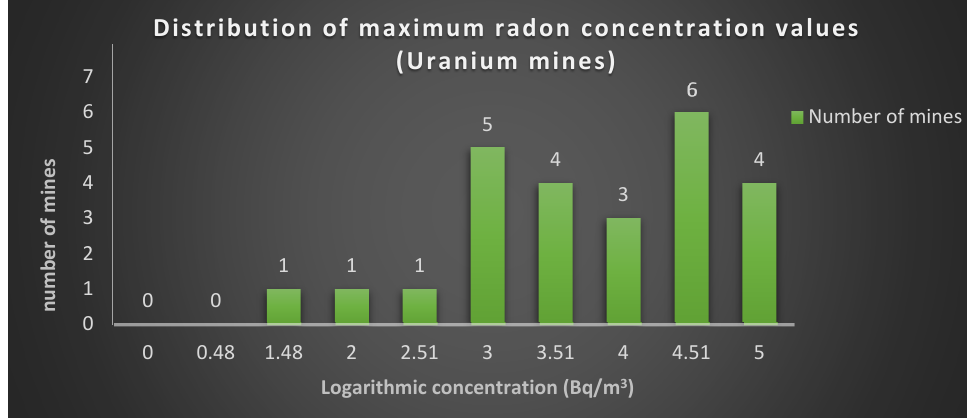
Figure 1. Distribution of radon concentration in uranium mines .